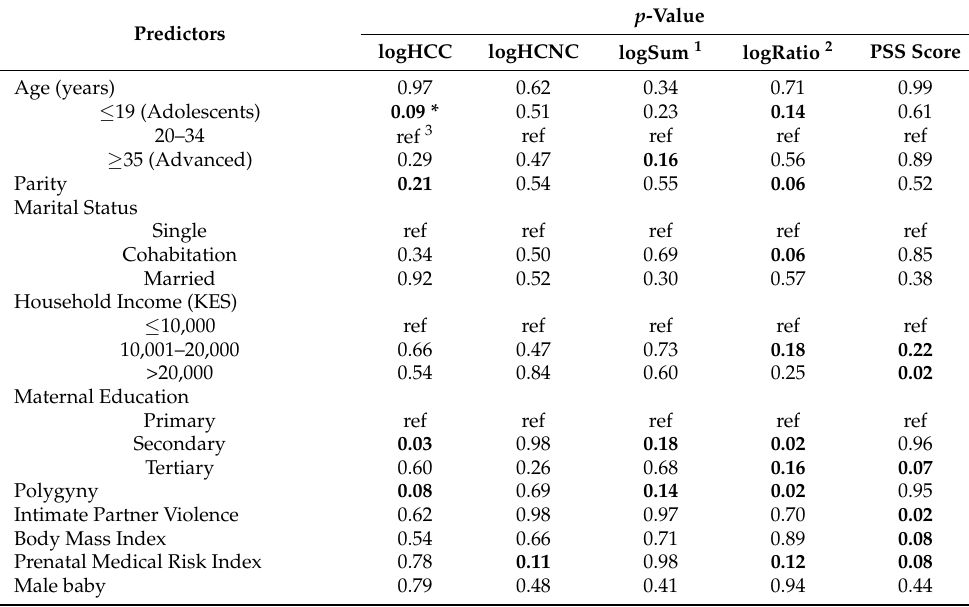
Table 3. Summary of bivariate analysis using simple linear regression.